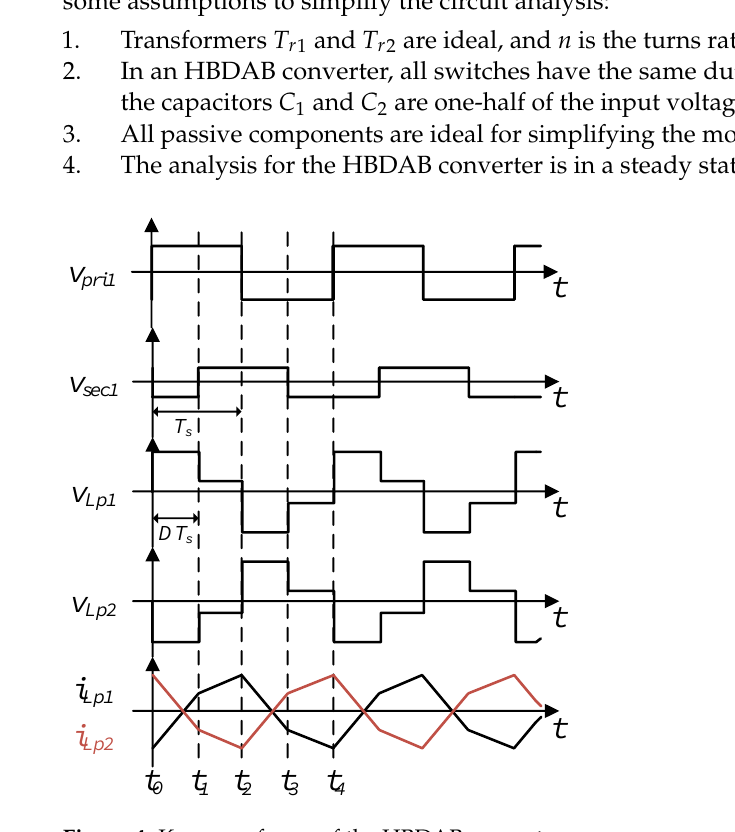
(d) Figure 5. Operation modes of the HBDAB converter. ( a ) Mode 1 ( b ) Mode 2 ( c ) Mode 3 ( d ) Mode 4.